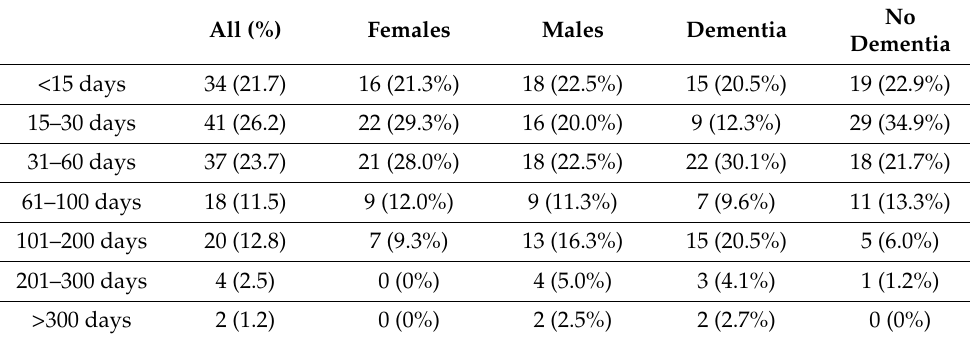
Table 2. ALC lengths of stay.